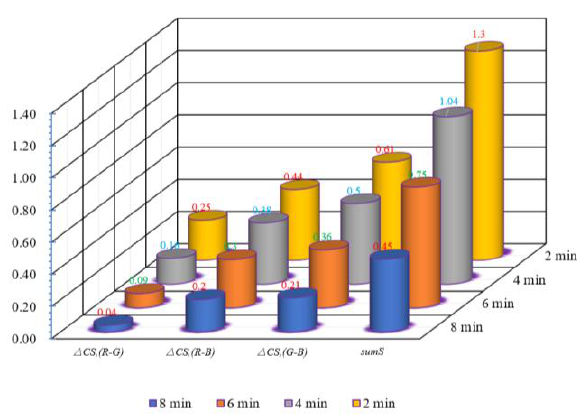
Figure 14. The change and trend of △ C S,(R-G) , △ C S,(R-B) , △ C S,(G-B) , and sum S with the increase of the fixation time.